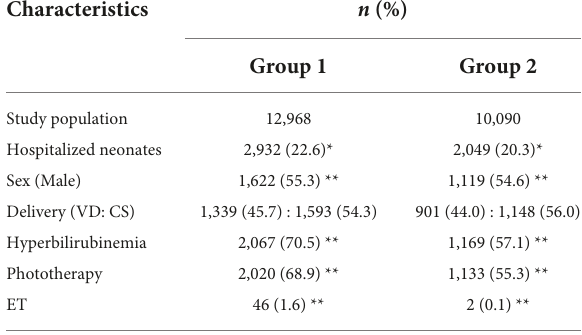
TABLE 1 Characteristics of the Group 1 and Group 2 neonates born at the Central Women’s Hospital Yangon, Myanmar.